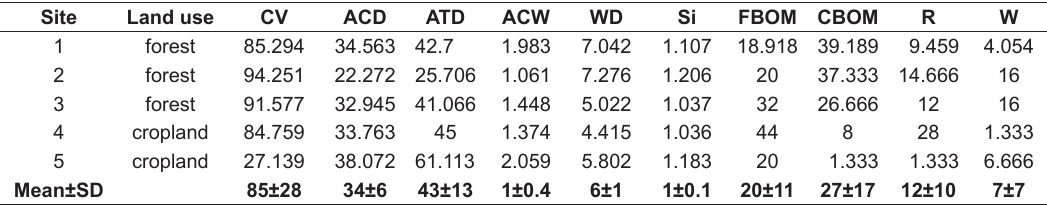
Table 2. Environmental variables of five streams located in the transition zone between the Amazon and Cerrado Biomes.